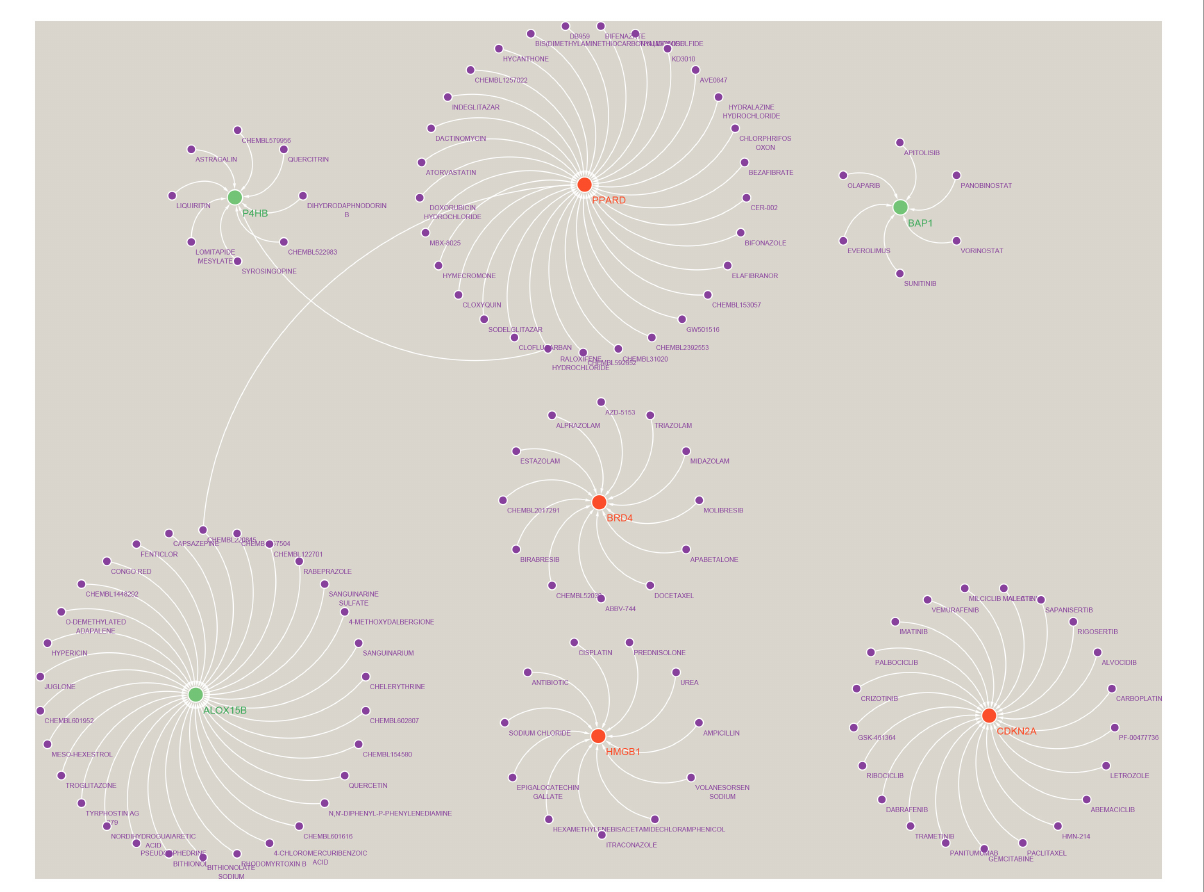
FIGURE11 Prediction of marker gene-targeted drugs. A total of 117 drugs were retrieved that acted on the Hub gene. Of these, 30 drugs targeted ALOX15B and PPARD; 21 drugs targeted CDKN2A; 12 drugs targeted BRD4; 11 drugs acted on HMGB1; 9 drugs acted on P4HB; and 6 drugs targeted BAP1, respectively. Where red orbs represent up-regulated mRNA, green orbs represent down-regulated mRNA, and purple orbs represent